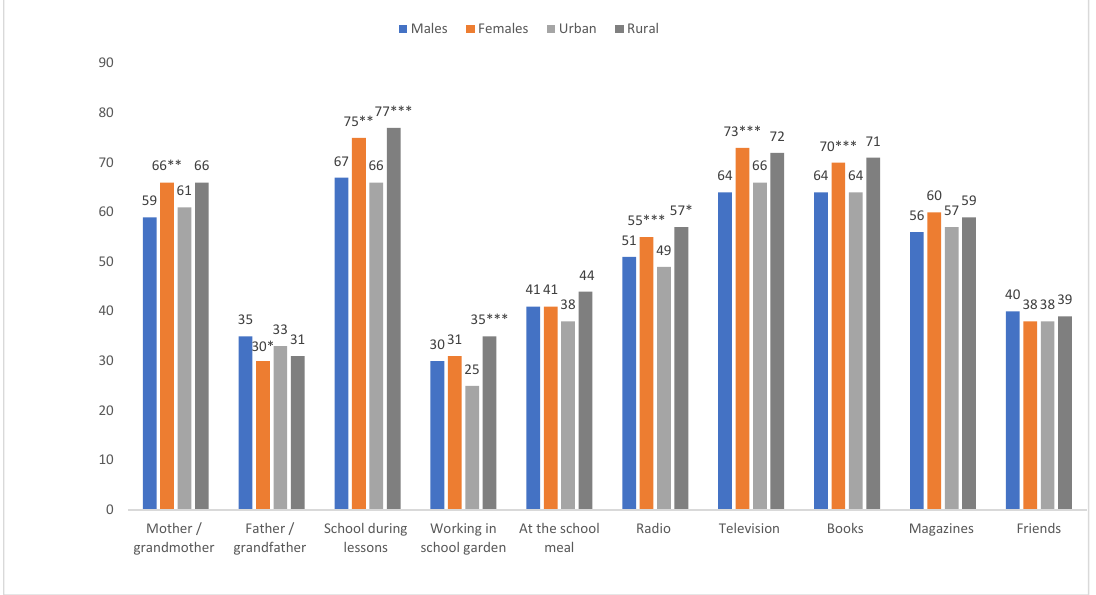
Figure 3. Sources of nutrition information for learners by gender and urban rural locations (figures take to nearest whole number). * Statistically significant at p < 0.05; ** p < 0.01; *** p < 0.001 (Rao – Scott chi-square test).